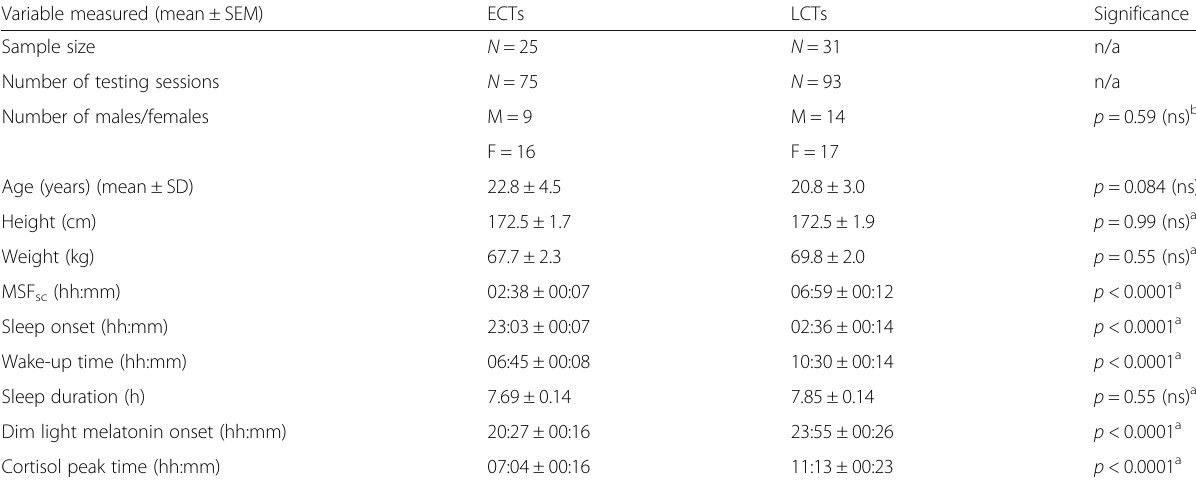
Table 1 Summary of demographic data, sleep and physiological variables for early (ECT) and late (LCT) chronotypes Variable measured (mean ± SEM)